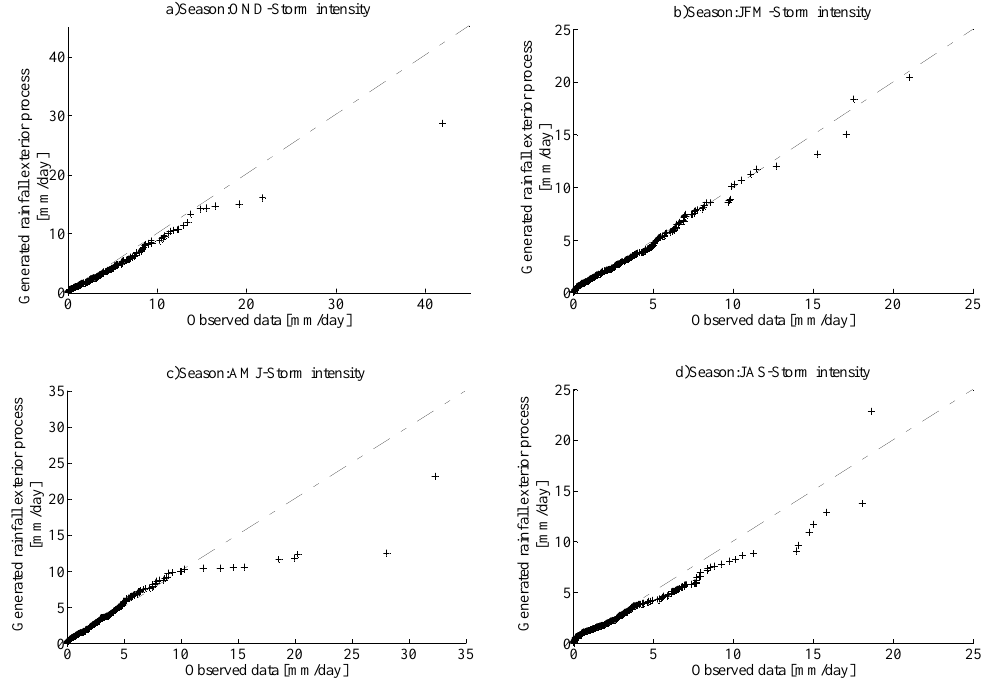
Fig. 8. Distributional agreement of storm intensity relative to cell #4 represented by the quantile-quantile plots between observations and the generated rainfall exterior process, corresponding to the calibration period (1961–1990) in autumn (a) , winter (b) , spring (c) and summer (d) .